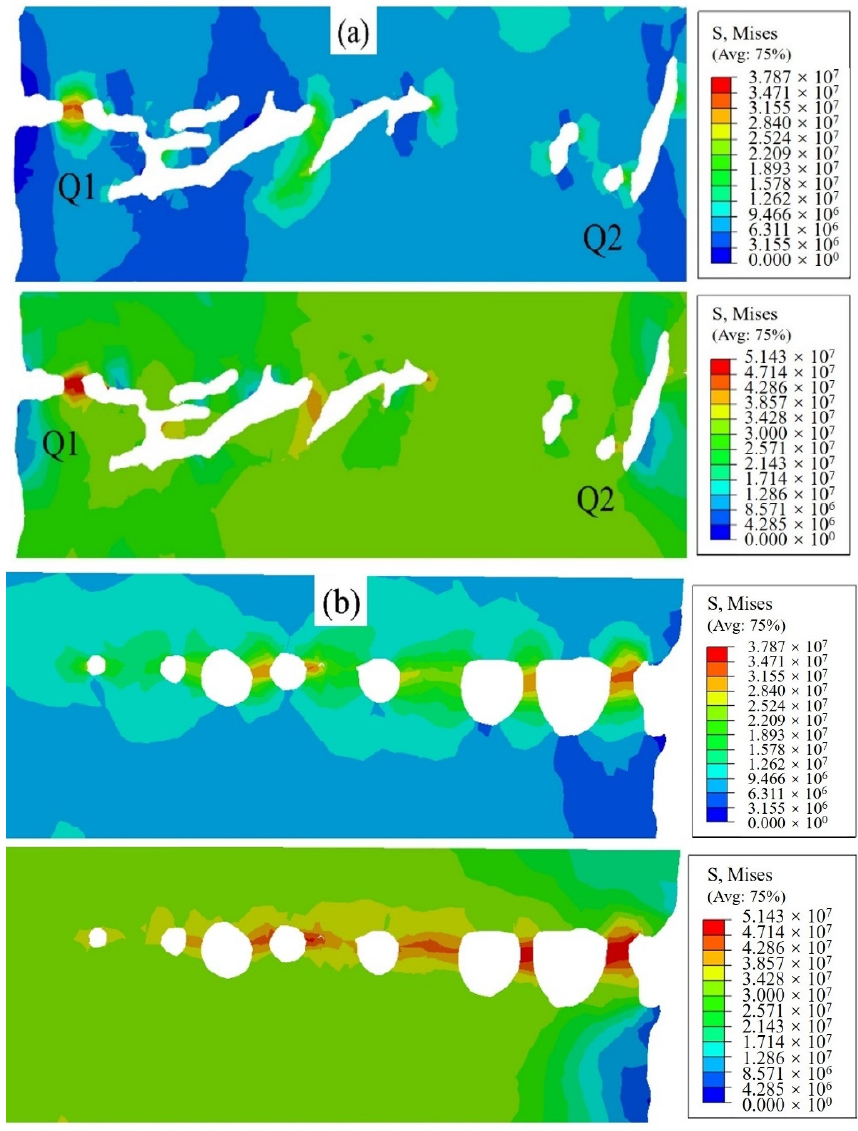
Figure 12. Stress distribution ( a ) near flaky cracks in regions Q1 and Q2 and ( b ) near aggregation pores in region Q2, under different external loads.